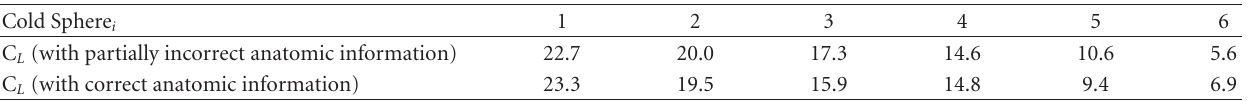
Table 2: Local contrast C L (expressed in %) with and without correct anatomic information obtained from the restored image with J 4 ( u ) . Cold Sphere i 1 C L (with partially incorrect anatomic information)